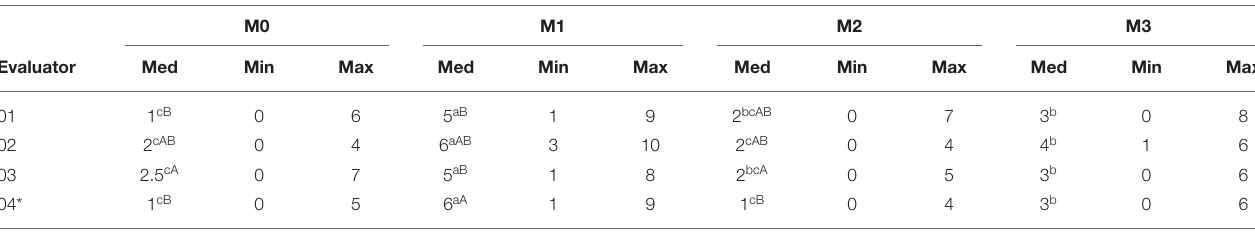
TABLE 5 | Median (amplitude) total scores of the DOPS from all